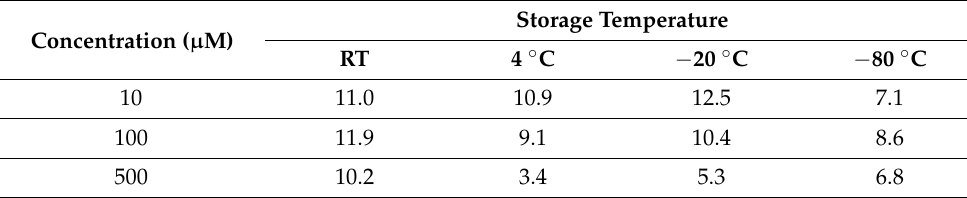
Table 4. Sample stability after 6 weeks of storage expressed as the % peak area variation relative to day